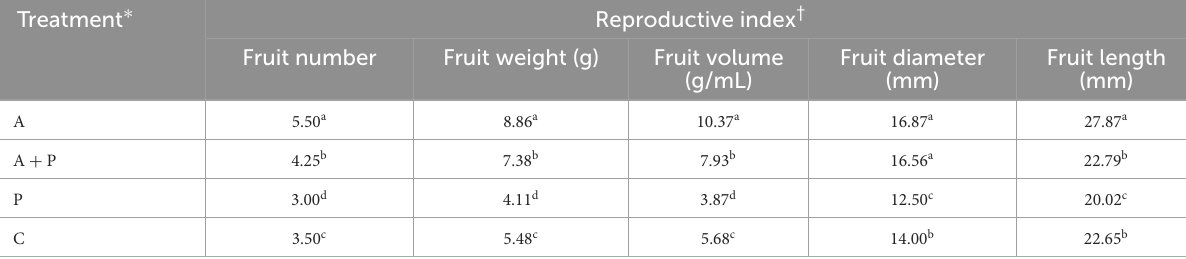
TABLE 3 Effect of different treatments on reproductive indices of the strawberry